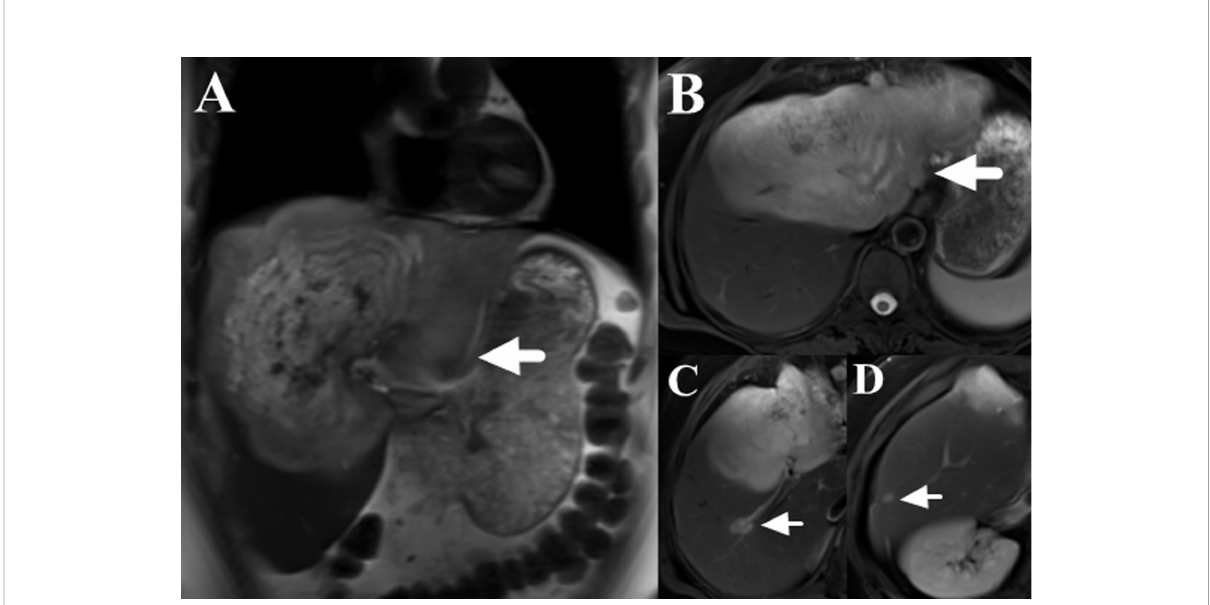
FIGURE 1 T2-weighted images of liver MRI (TR/TE: 7059/85 ms; fi eld of view: 44 × 40 cm; matrix: 320 × 224; thickness: 8 mm), which showed a giant heterogenous high signal intensity tumor mainly located in the left lobe ( A, B, marked with arrows) and multiple small high signal intensity lesions in the right lobe ( C, D, marked with